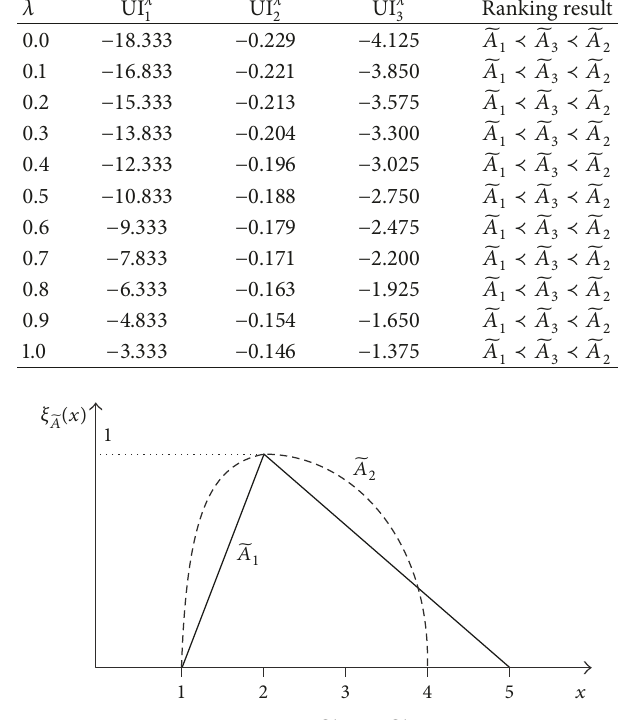
Figure 9: Fuzzy numbers